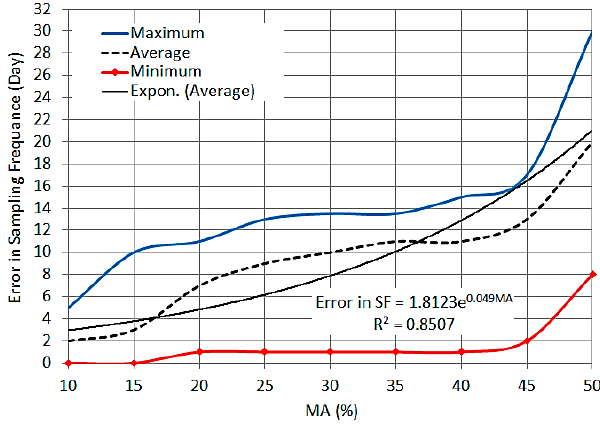
Figure 10. Relationship of SF versus MA.